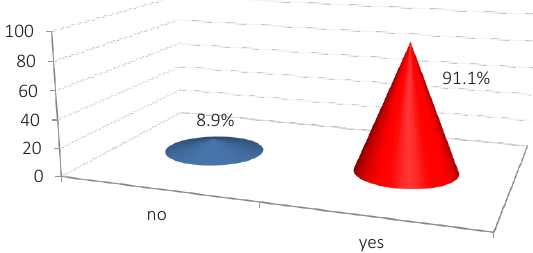
Figure 4. Perception of How Getting Information Reduces Risk of Illness While